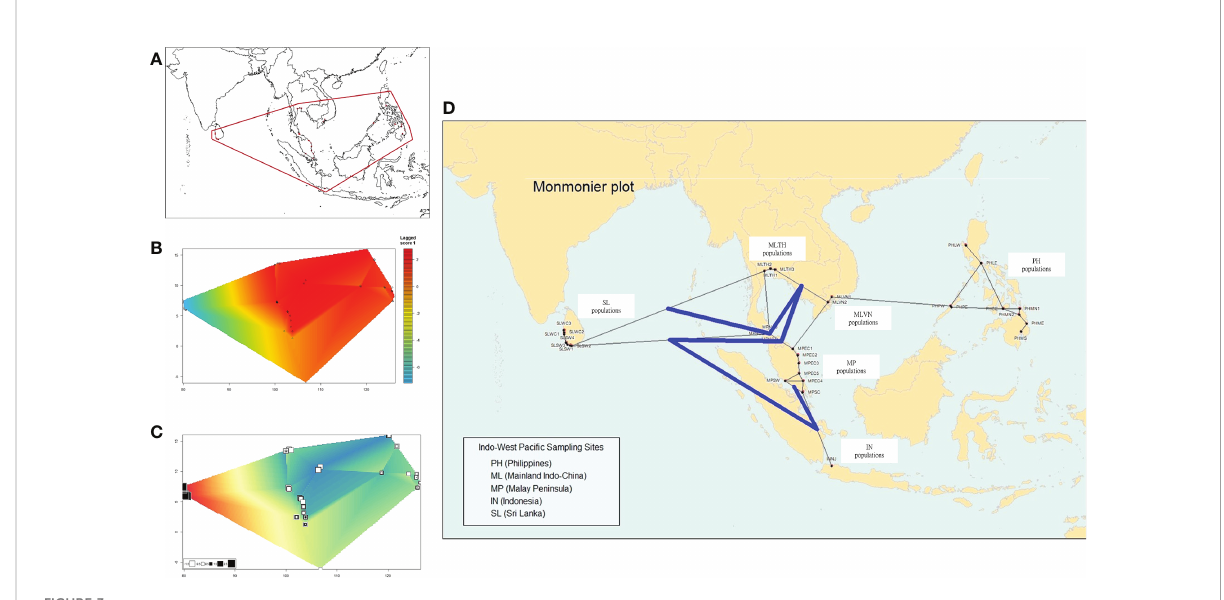
FIGURE 3 Spatial correlations and genetic differentiation of nipa populations based on the sPCA method. (A) Distribution of sampling locations, which serves as the range used in the following spatial analysis in B – D . (B) Overall genetic divergence and spatial connectivity of populations. The color bars on the right indicate the degree of population structure: the dark red means the populations are globally structured while the blue indicates no similarity between two individuals (extremely locally structured). (C) The fi rst axis (PC) of the sPCA plot. (D) The Monmonier plot of genetic boundaries (solid blue line) shows that the Malay Peninsula is a genetic barrier among the connection network of nipa populations in